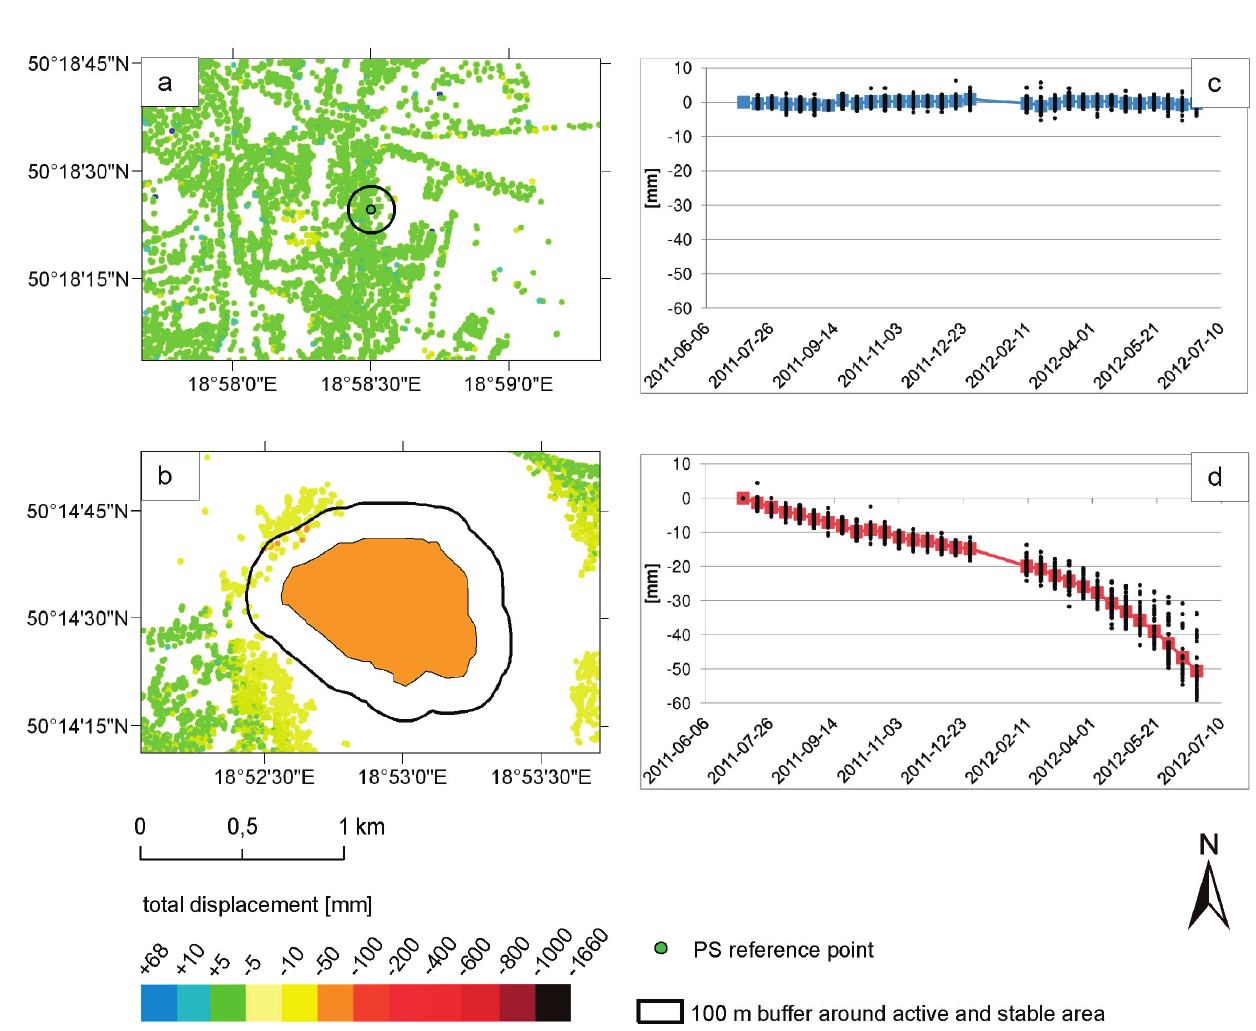
Figure 10. ( a ) Cumulated displacement measured on Permanent Scatterers Interferometry (PSI) points in the area of the reference point (Figure 4); ( b ) cumulated displacement measured for the subsidence trough no. 19 “Klodnica” (Figure 8, Table 4) superimposed on the PSI cumulated displacement; ( c ) time series of PSI around 100 m of the reference point. In blue squares the averaged value; and ( d ) time series of PSI around 100 m of the subsidence trough from (b). In red squares the averaged